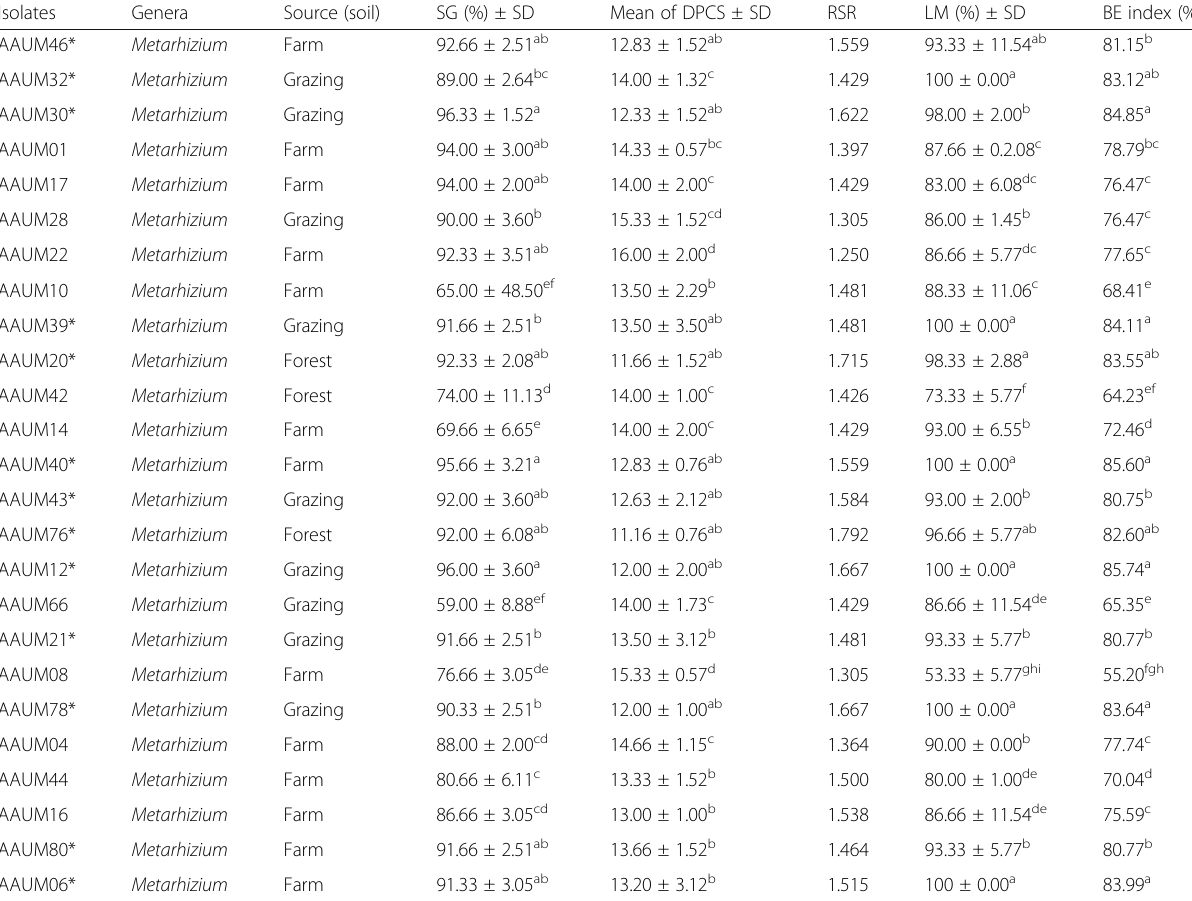
Table 1 Prescreening and biological efficiency index calculation of isolates based on spore germination, culture sporulation dates, and larval mortality of Galleria mellonella at 1 × 10 8 spore ml − 1 in 10 days of post inoculation